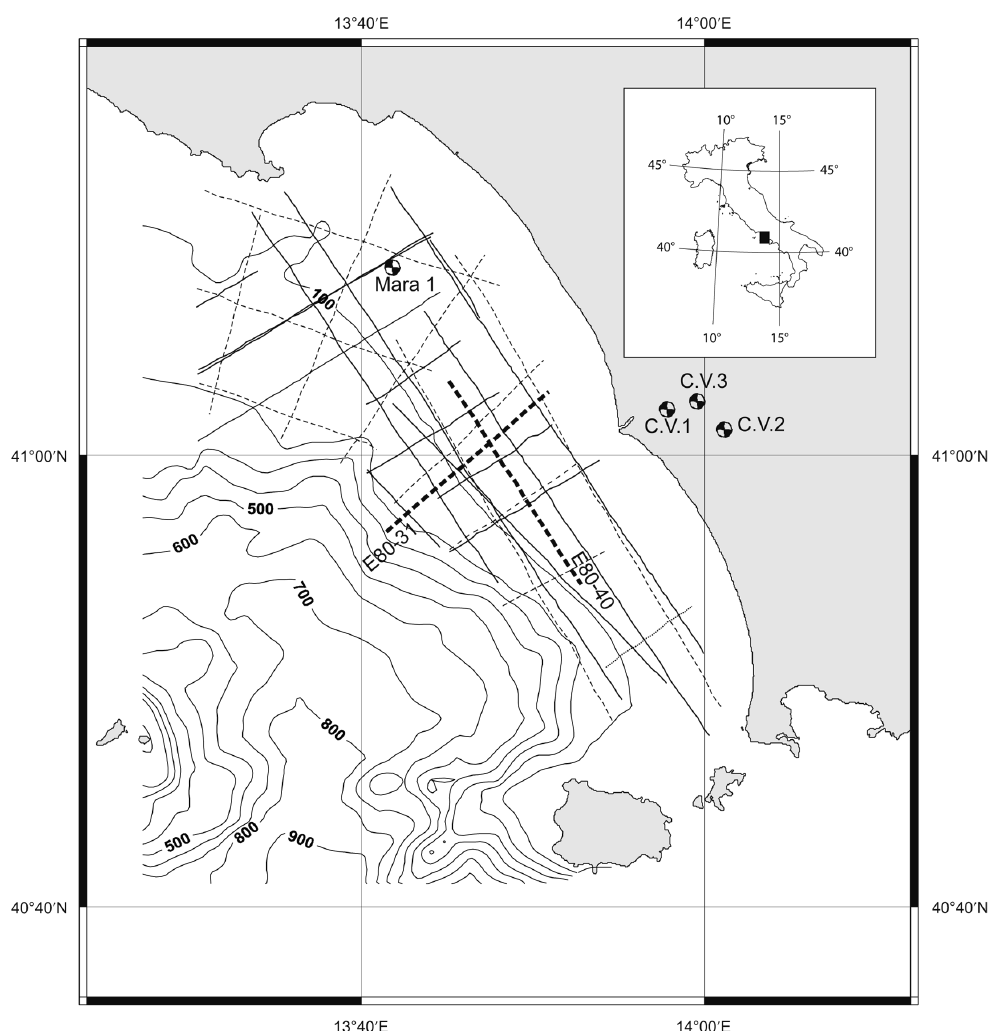
Fig. 2. Geophysical dataset used in this study. 1968 regional multichannel seismic grid (Aquapulse © source): thin dashed lines; GMS92 and GMS93 magnetometric grids acquired during R/V Urania cruises in 1992 and 1993: thin continuous lines. E80-31 and E80-40 (bold dashed lines) are two multichannel seismic profiles pro- vided by Agip company and shown in figs. 3 and 4. Location of Mara 1 and Castel Volturno (CV) wells drilled offshore and onshore by Agip is